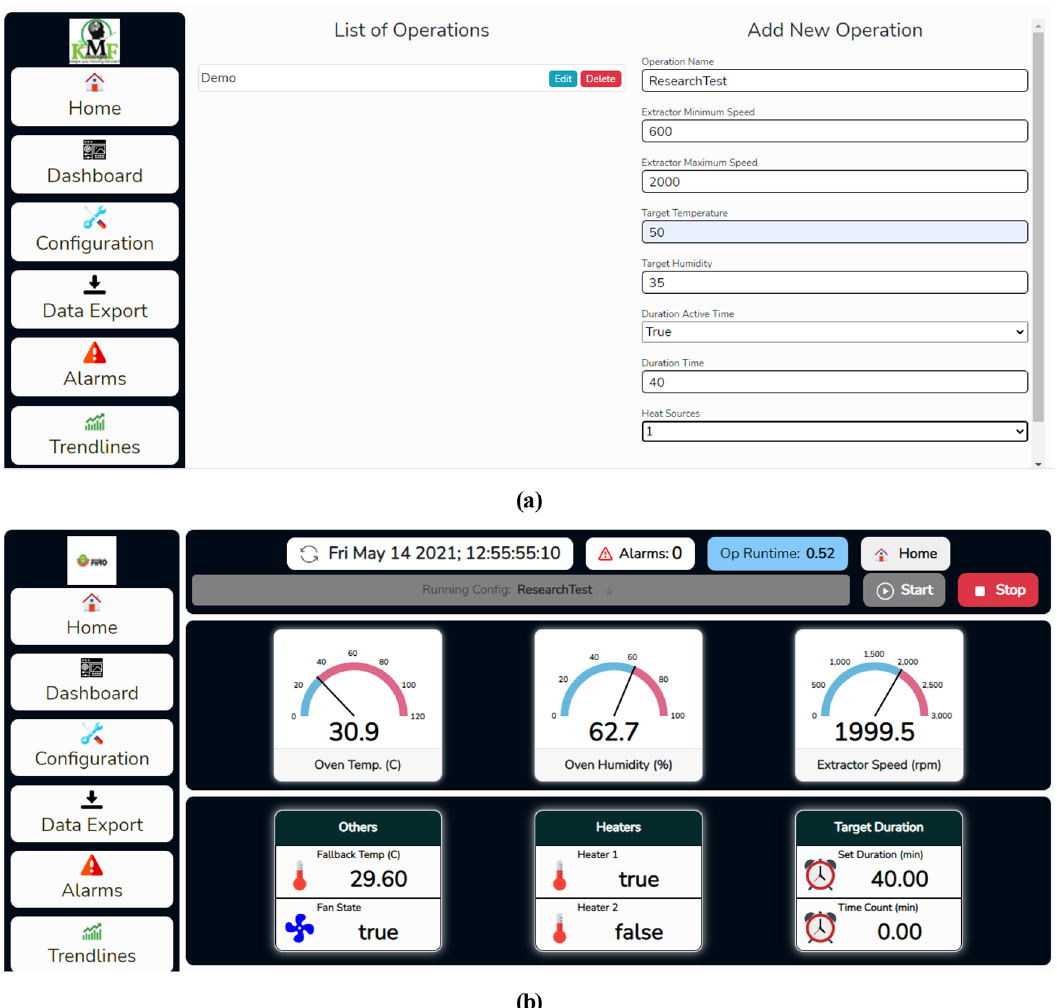
Figure 13. (a) Creating an operation profile on the dehydrator web app. (b) Dashboard